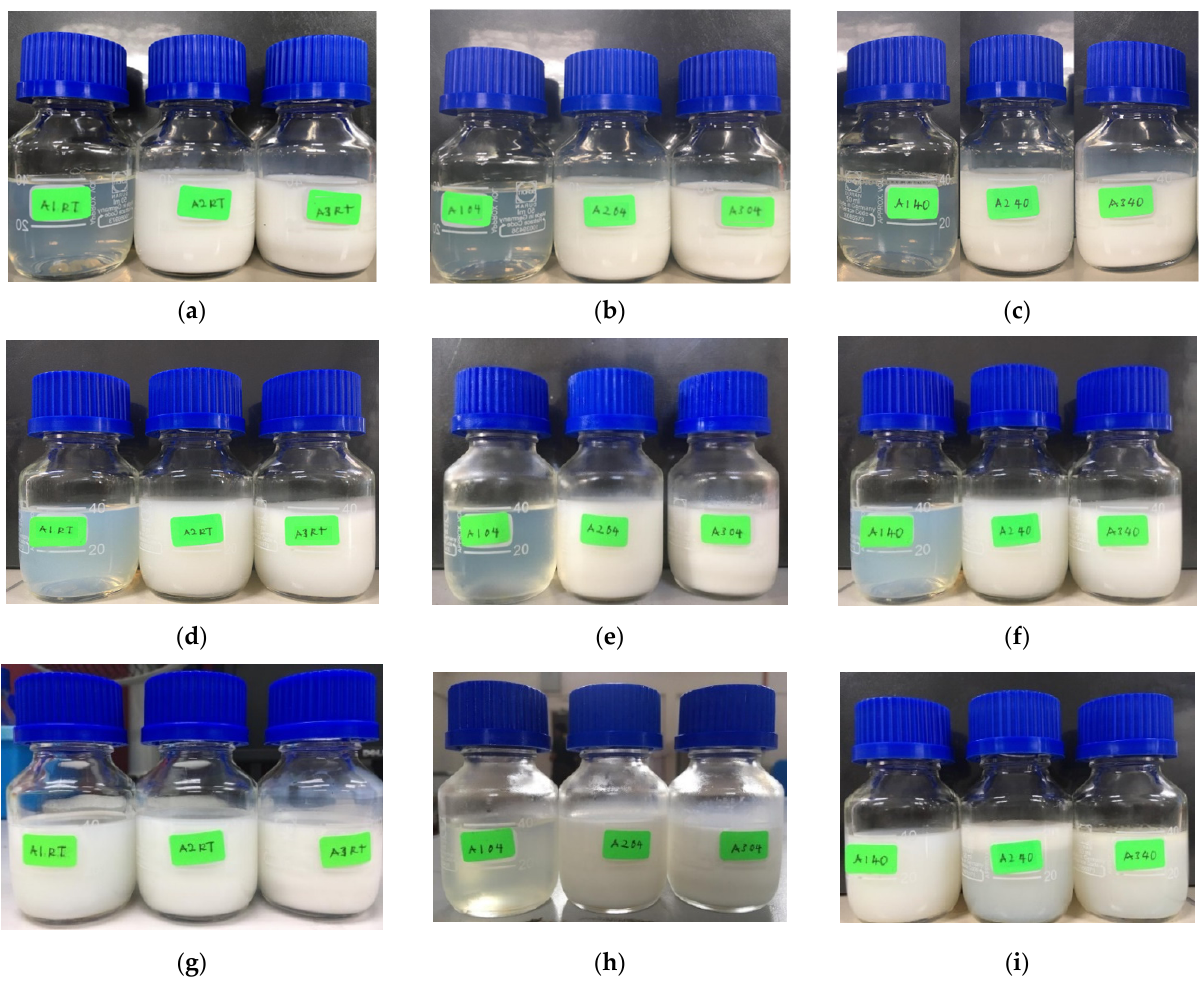
Figure 1. The changes in physical appearance of SBH NEs. From left to right, the samples are denoted as A1, A2, and A3, kept for 0 days’ storage at room temperature ( a ), 4 ◦ C ( b ) and 40 ◦ C ( c ); 7 days’ storage at room temperature ( d ), 4 ◦ C ( e ), and 40 ◦ C ( f ); and 14 days’ storage at room temperature ( g ), 4 ◦ C ( h ), and 40 ◦ C ( i